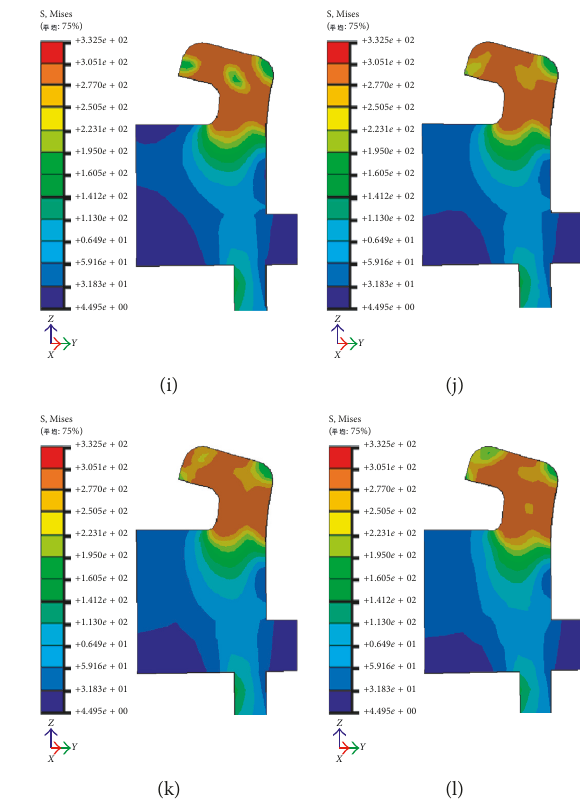
66 ° , (cid:30) 70 ° , (d) c 72 ° , (e) c 74 ° , (f) c 76 ° , (g) (cid:30) (cid:30) (cid:30) (cid:30) 80 ° , (i) c 82 ° , (j) c 84 ° , (k) c 86 ° , and (l) (cid:30) (cid:30) (cid:30) (cid:30)